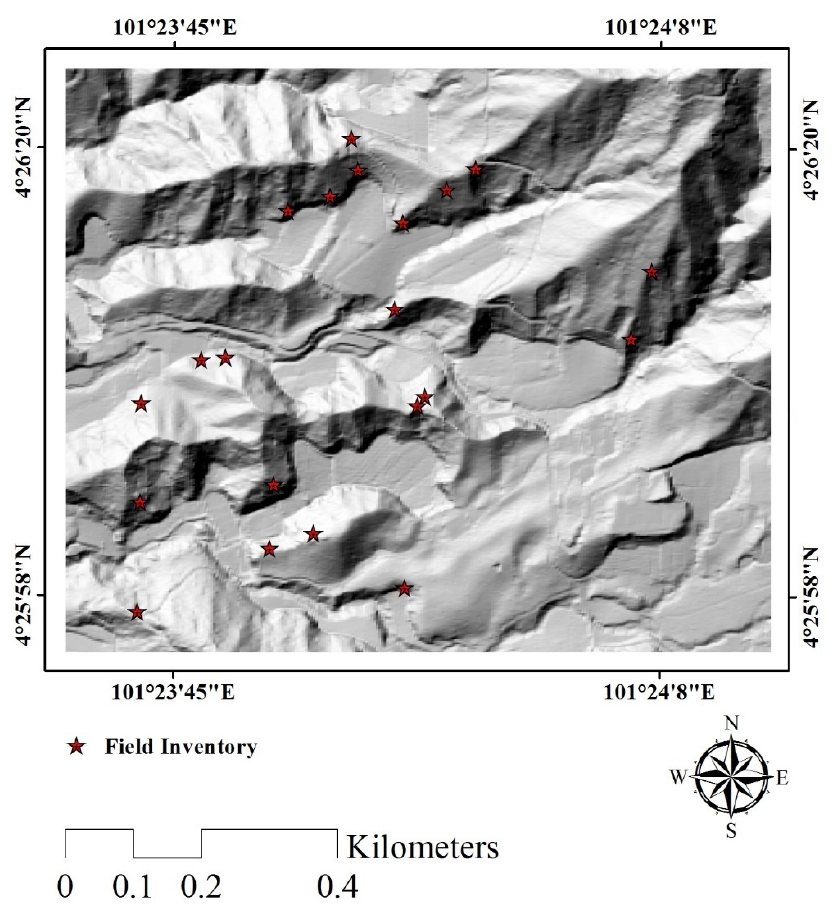
Figure 3. Shows the locations of landslide in the study